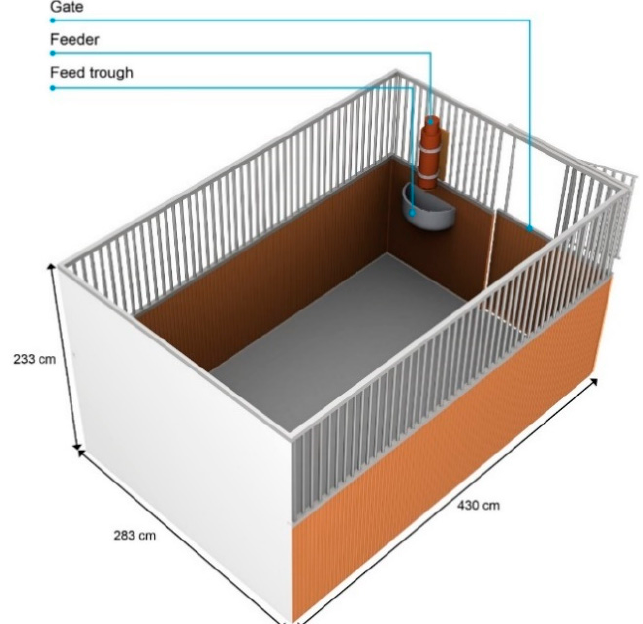
Figure 1. The horse’s box as experimental area, type A. See Supplementary Material Figure S1 and S2 for type